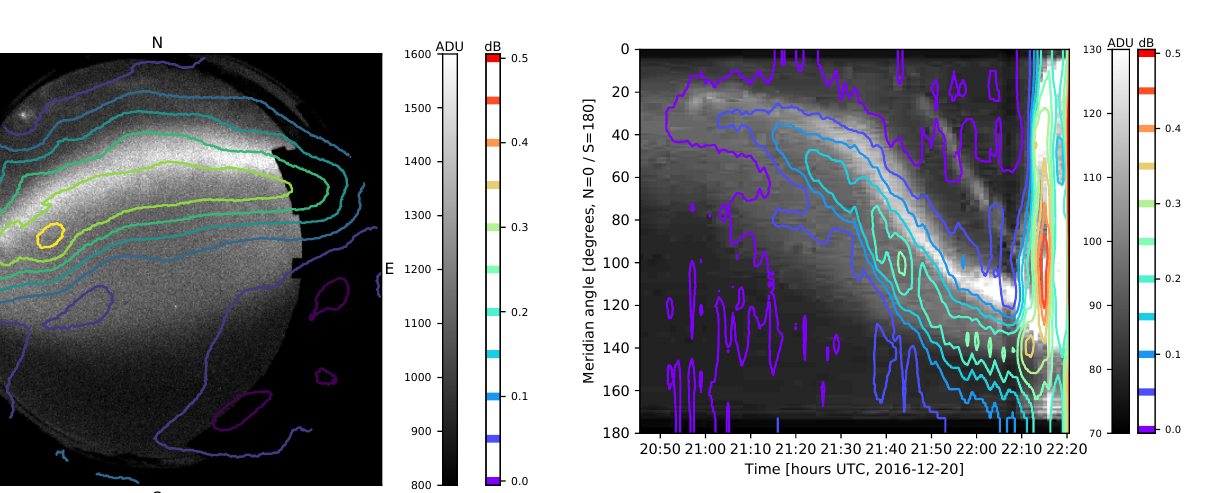
Figure 2. Imaging riometer contour lines plotted over an opti- cal all-sky image 20 December 2016 21:30UTC. The dislocation of the optical growth-phase arc and the CNA absorption can be clearly seen. The CNA > 0.35dB in the centre left of the image is an artefact from ionospheric scintillation of the radio source Cas- siopeia A. Approximate cardinal directions are marked for refer- ence. See Sect. 2.1 for a detailed description of the projection.